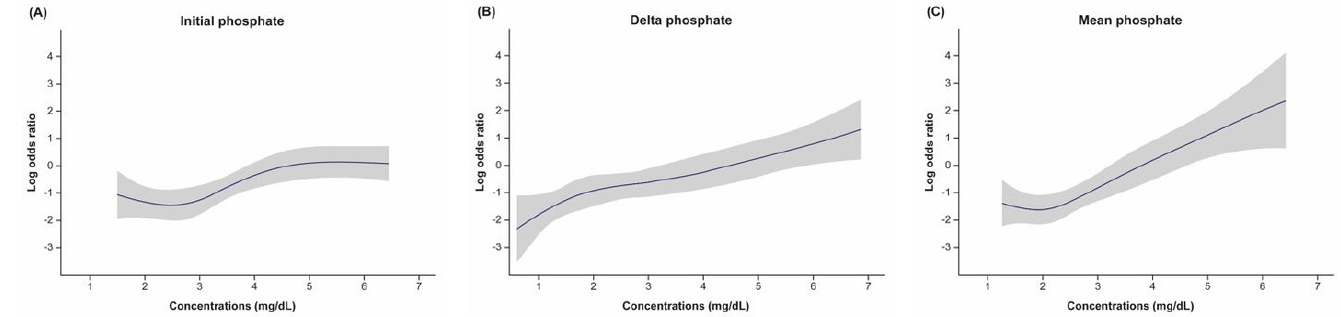
Figure 3. Log odds graphs evaluating hospital mortality risk according to phosphate values in each category. The shading indicates 95% confidence intervals. ( A ) Initial phosphate: the first phosphate value measured within 24 h of admission to the intensive care unit (ICU). ( B ) Delta phosphate: the range of change obtained by subtracting the minimum phosphate concentration from the maximum phosphate concentration measured during the ICU stay. ( C ) Mean phosphate: the arithmetic mean value for phosphate concentrations measured during the ICU stay.